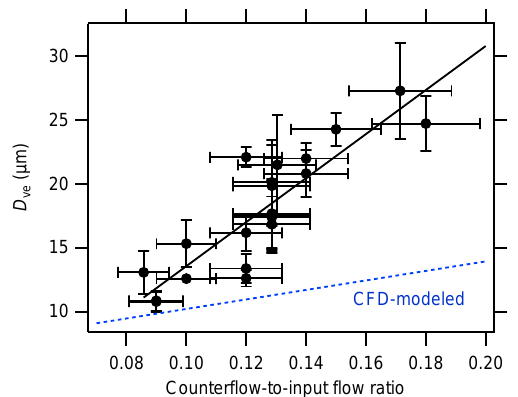
Figure 8. Droplet cut-size spectrum as a function of the CF-to-IF ratio. During our validation tests, we systematically varied the IS- PCVI flow conditions (Table